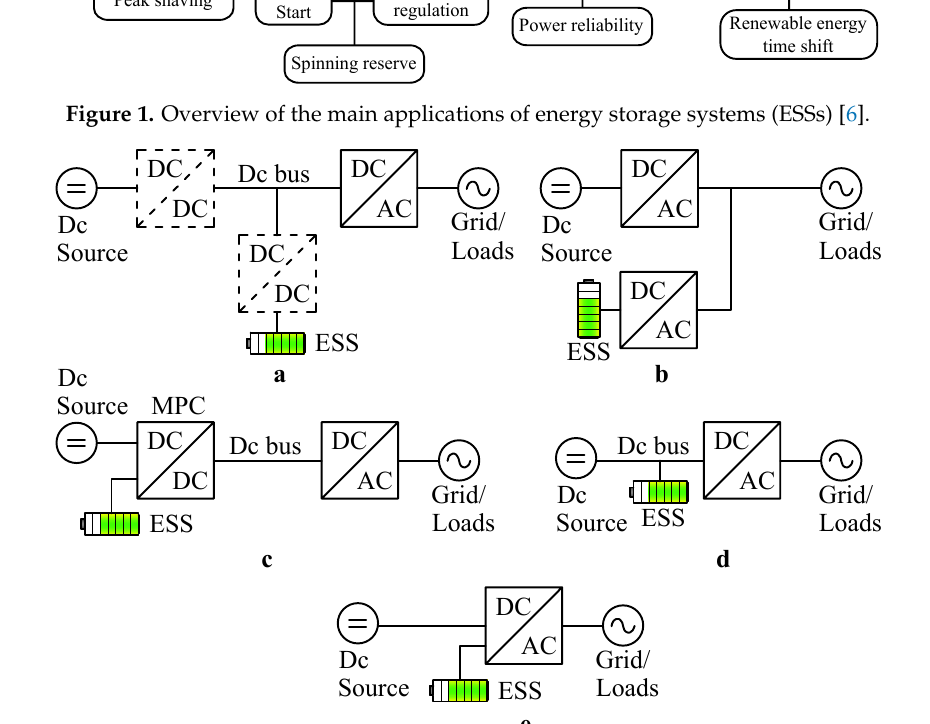
Figure 2. Main configurations for connecting the energy storage system (ESS). ( a ) Connection to the DC bus of the inverter through a bidirectional DC-DC converter; ( b ) Connection to the AC bus through a dedicated inverter; ( c ) Connection using a DC-DC multiport converter (MPC); ( d ) Direct connection to the DC bus; and ( e ) Direct connection to the inverter